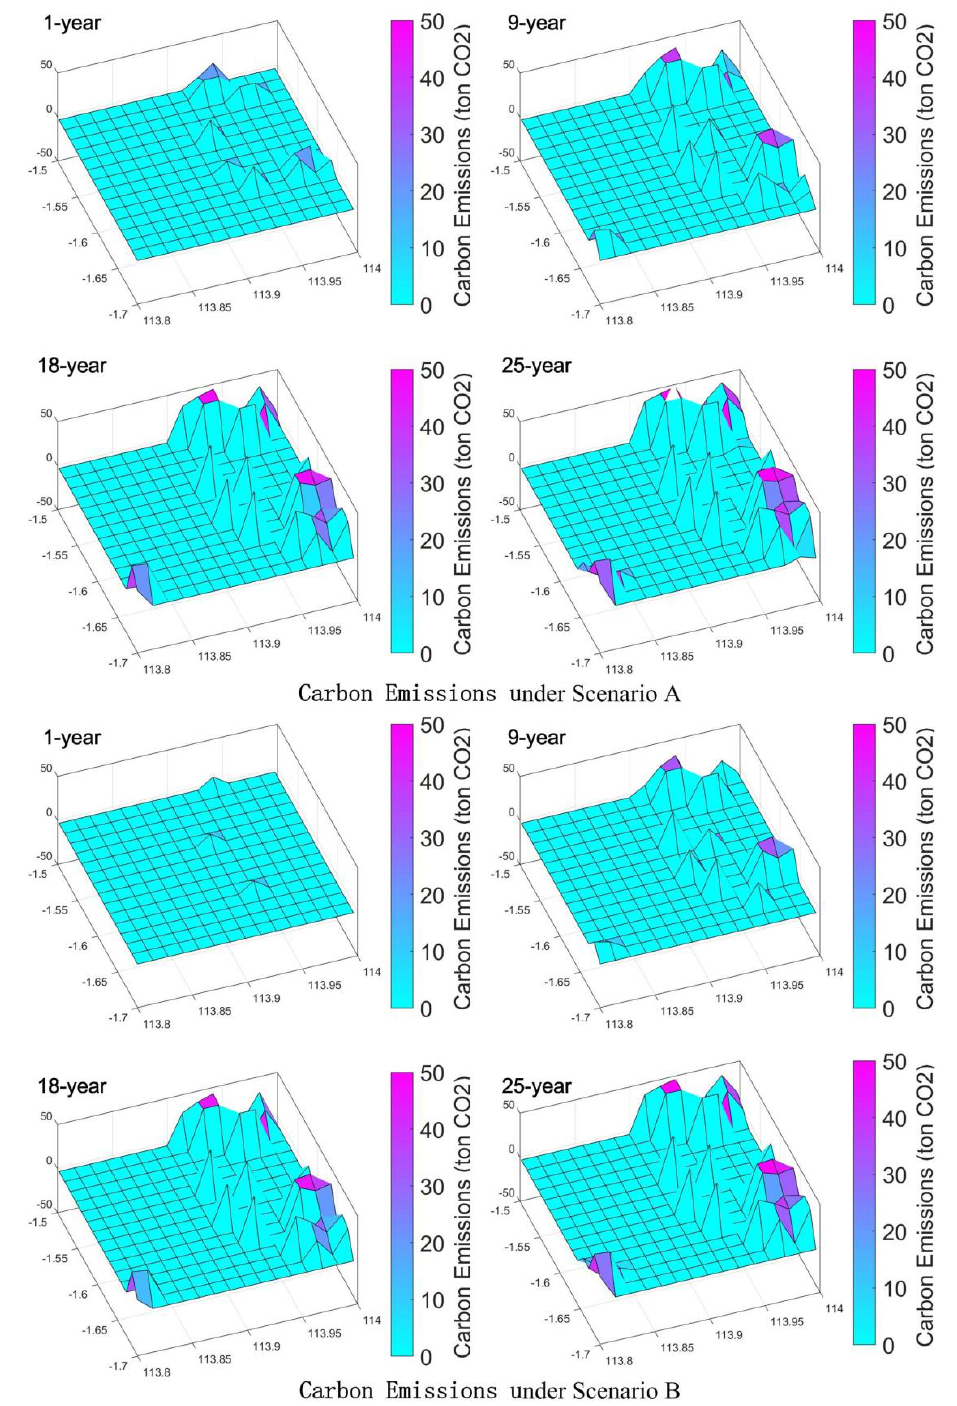
Figure 2. In both color and height, three-dimensional graphs display subtle variations of carbon emissions by predicting future land use changes under two scenarios: (1) Scenario A : without consideration of carbon sequestration in plantations, and (2) Scenario B : with consideration of carbon sequestration in plantations. X axes represent longitude, Y axes represent latitude, and Z axes represent carbon emissions from deforestation (unit: tonne CO 2 ) in study area of total 47.9 thousand hectares. The prediction of the net present value obtained from rice, logging, oil palm plantations, and rubber plantations using Equation (6) is illustrated in Figure 3. Oil palm plantations and rubber plantations will generate USD 15.2 million (with USD 1.57 million in six years) and USD 10.5